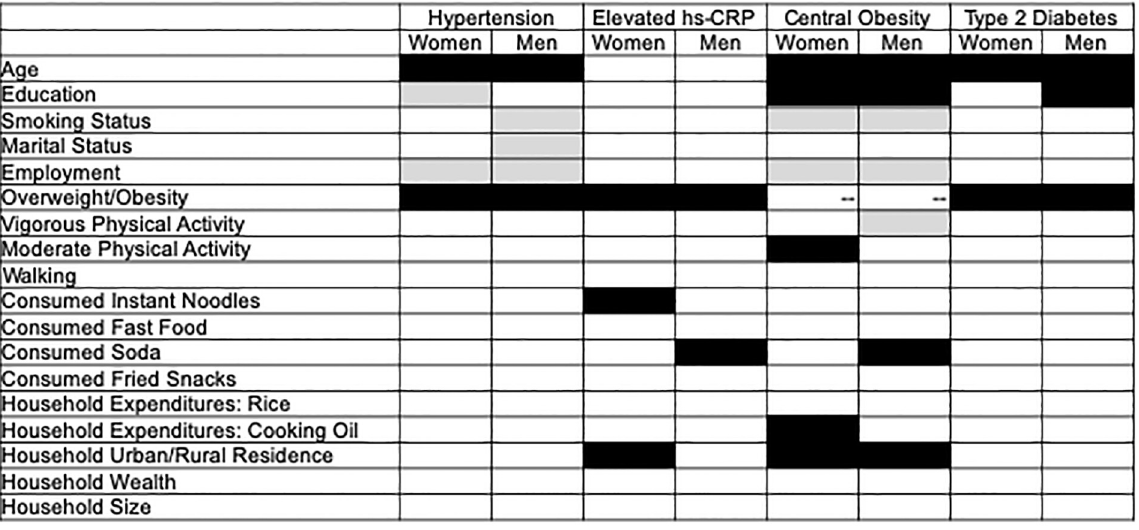
Fig 1. Summary of associations between selected characteristics and chronic disease among adults in multivariable models. --not applicable. Associated with higher odds of chronic disease outcome . Associated with lower odds of chronic disease outcome.